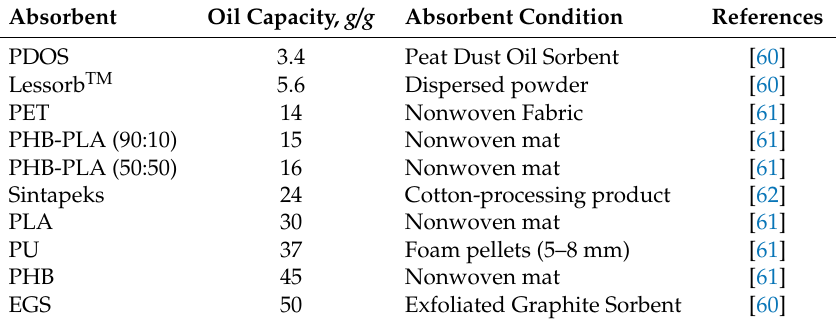
Table 4. Oil absorption for the productive polymer